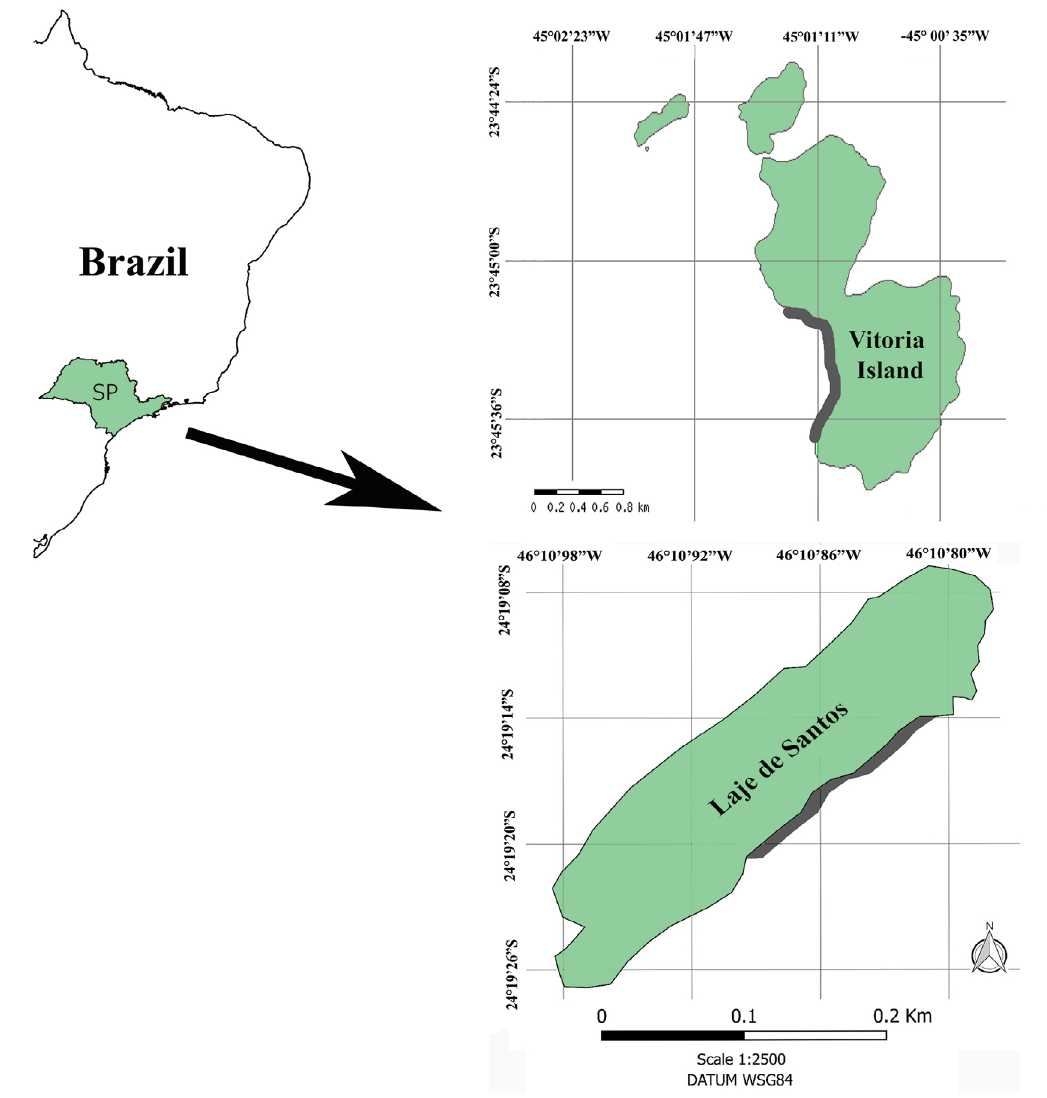
Figure 1. Location of the two continental islands, São Paulo State, Brazil, where the sampling was conducted for the present study